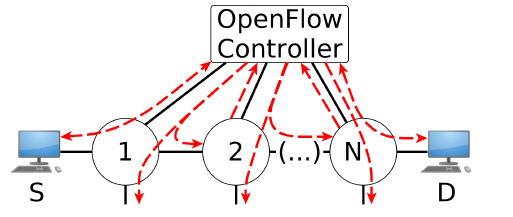
Figure 1. Topology discovery using flood